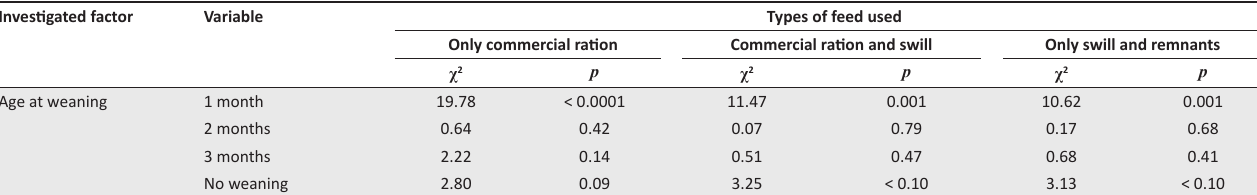
TABLE 4: Association between types of feed used and weaning